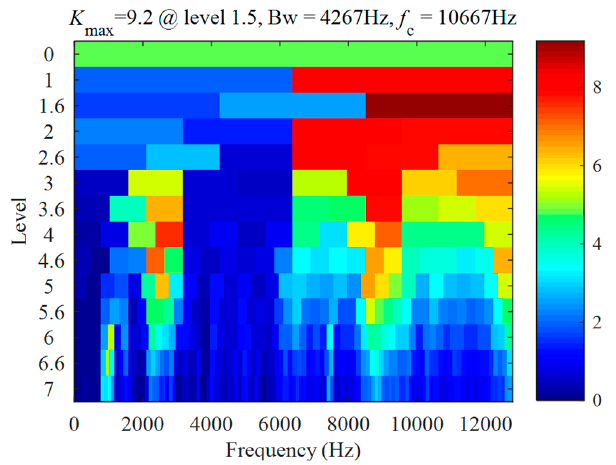
Figure 10. Case 2 for inner race defect: ( a ) Original signal; ( b ) filtered signal; ( c ) envelope; ( d ) compressed signal; ( e ) partial enlarged envelope; ( f ) partial enlarged compressed signal.